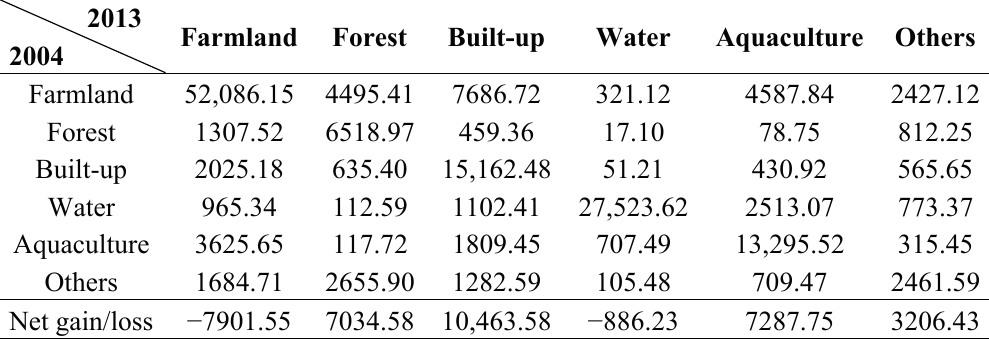
Table 3. Land use transition matrix between 2004 and 2013 in the study area (unit: